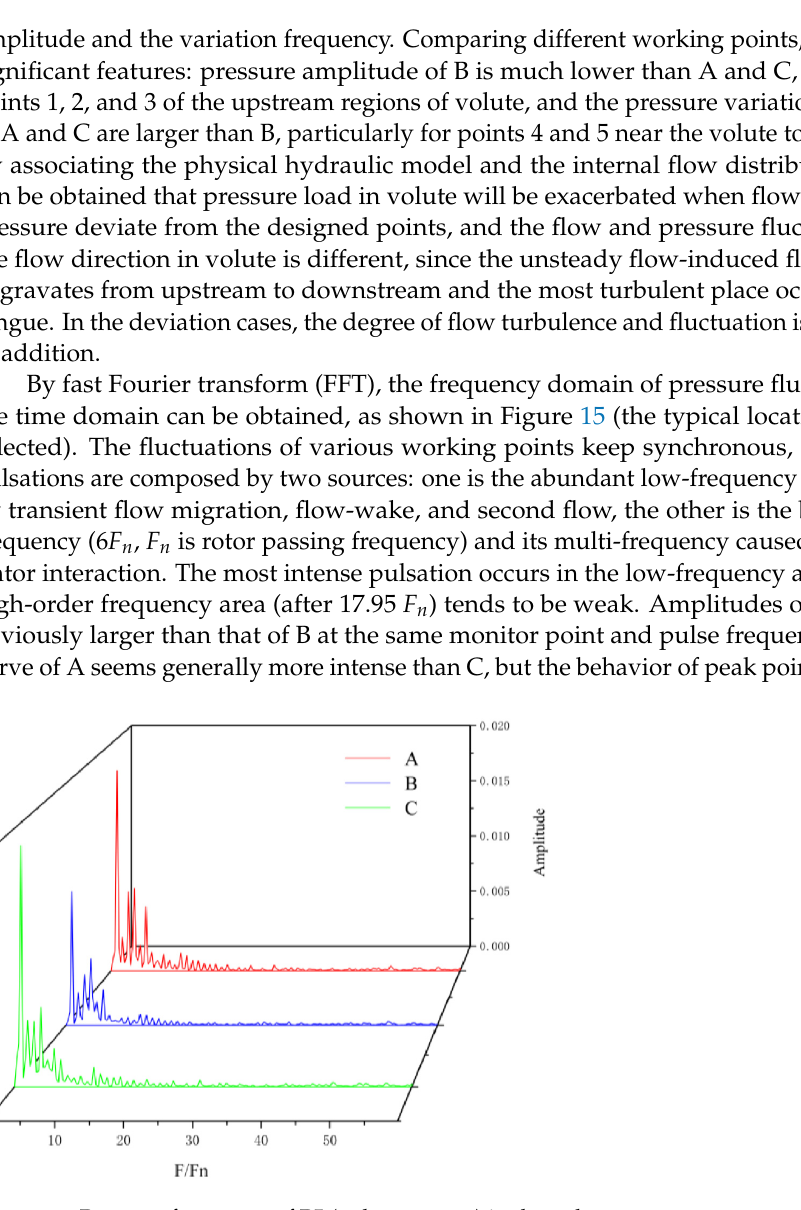
Figure 14. Pressure time domain in the volute.